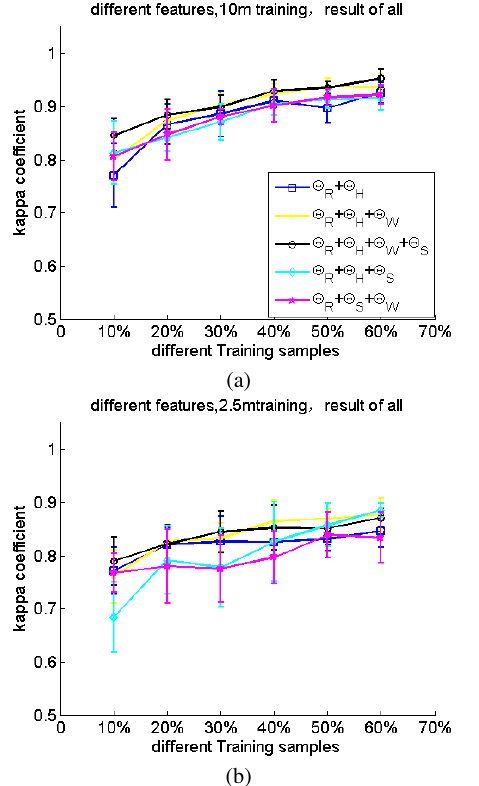
Figure 2: Classification results of different feature sets (a) when the images of 10m resolution is selected as training samples; and (b) when the images of 10m resolution is selected as training sam-